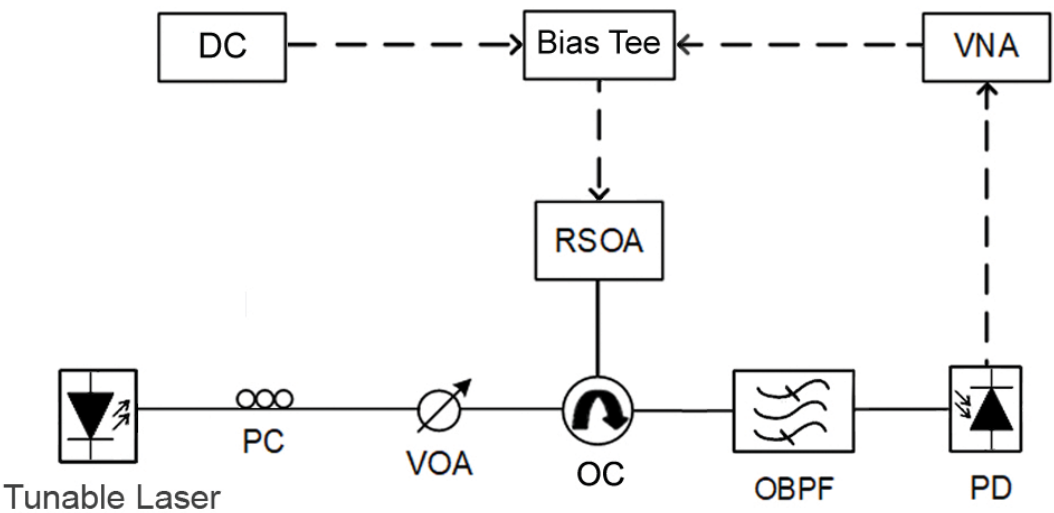
Figure 3. Experimental setup for measuring RSOA E/O response. RSOA: reflective semiconductor optical amplifier, VNA: vector network analyzer, OC: optical circulator, OBPF: optical bandpass filter, VOA: variable optical attenuator, PC: polarization controller, PD: photodiode. Solid and dashed lines show optical and electrical paths, respectively.